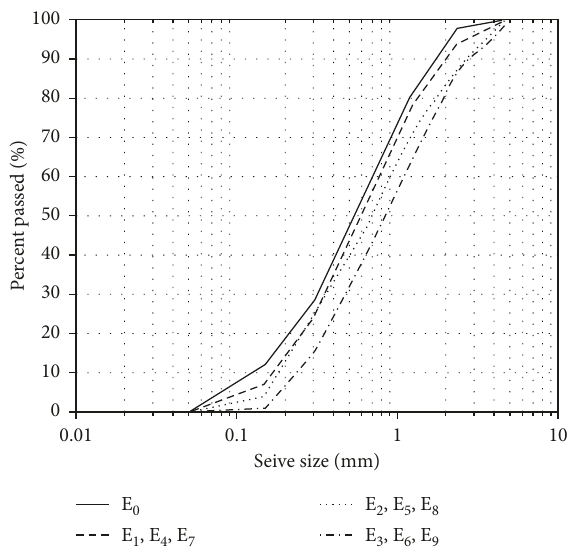
Figure 2: Aggregate gradation of